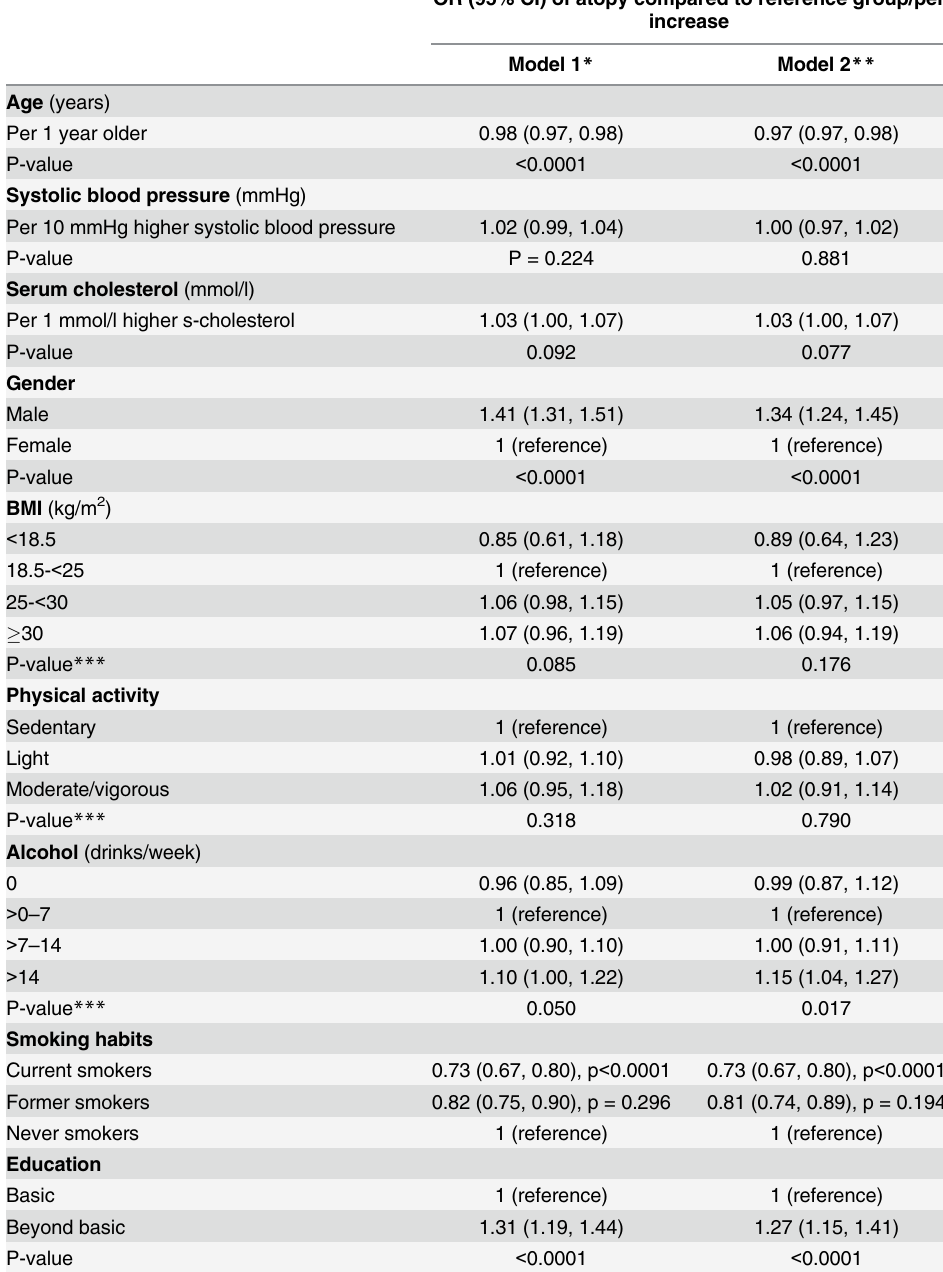
Table 2. The associations of atopy with possible factors of atopy (n = 15828). OR (95% CI) of atopy compared to reference group/per